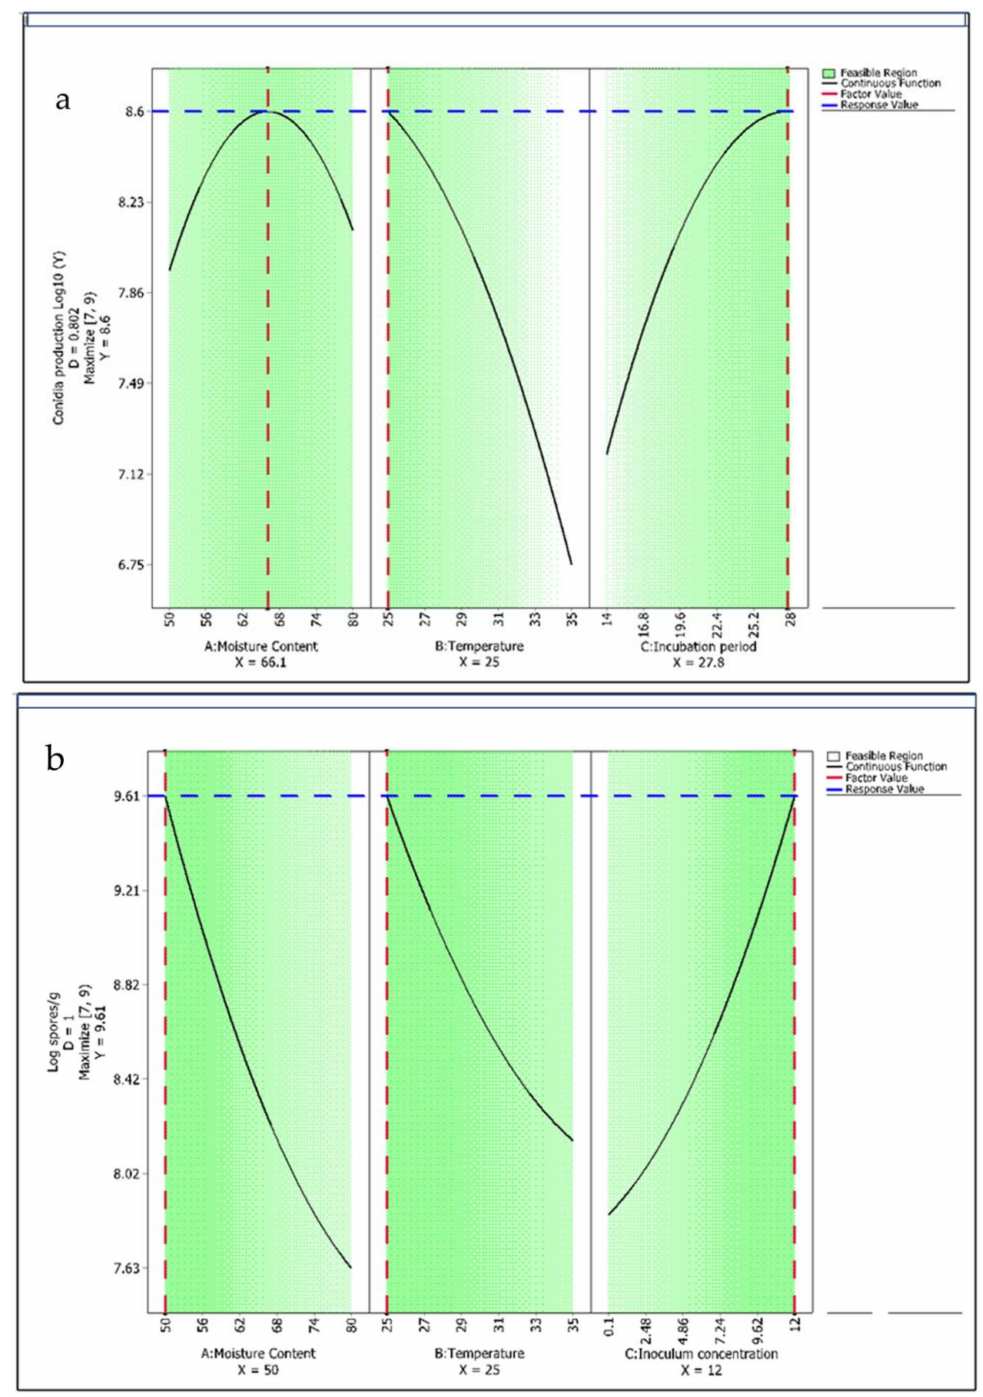
Figure 5. Optimal process conditions for biomass production of ( a ) T. asperellum AU131, and ( b ) T. longibrachiatum AU158 under